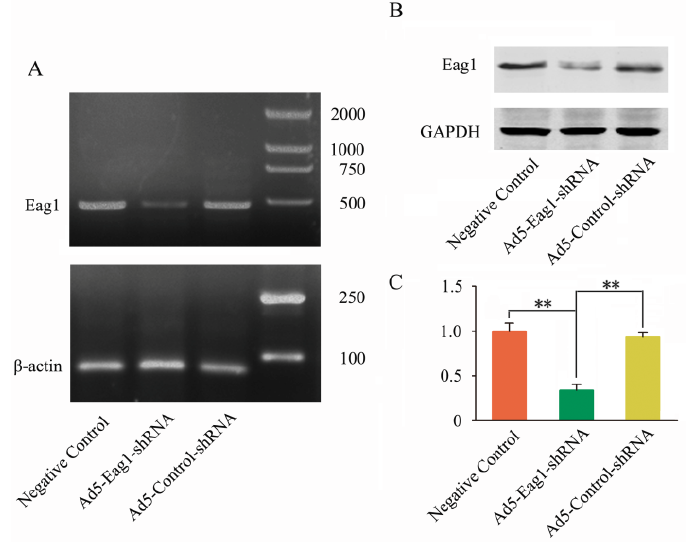
Figure 1. shRNA mediated knockdown of Ether à go-go 1 ( Eag1 ) in MG-63 cells. ( A ) RT-PCR analysis of Eag1 mRNA level in MG-63 cells treated with Eag1-shRNA. β -actin was internal control; ( B ) Western blot analysis of Eag1 protein level in MG-63 cells treated with Eag1-shRNA; ( C ) Densitometry analysis of Rag1 protein level. GAPDH